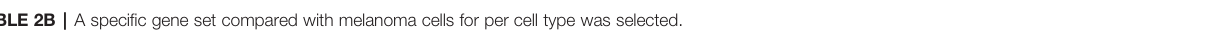
TABLE 2B | A speci fi c gene set compared with melanoma cells for per cell type was selected. Cell